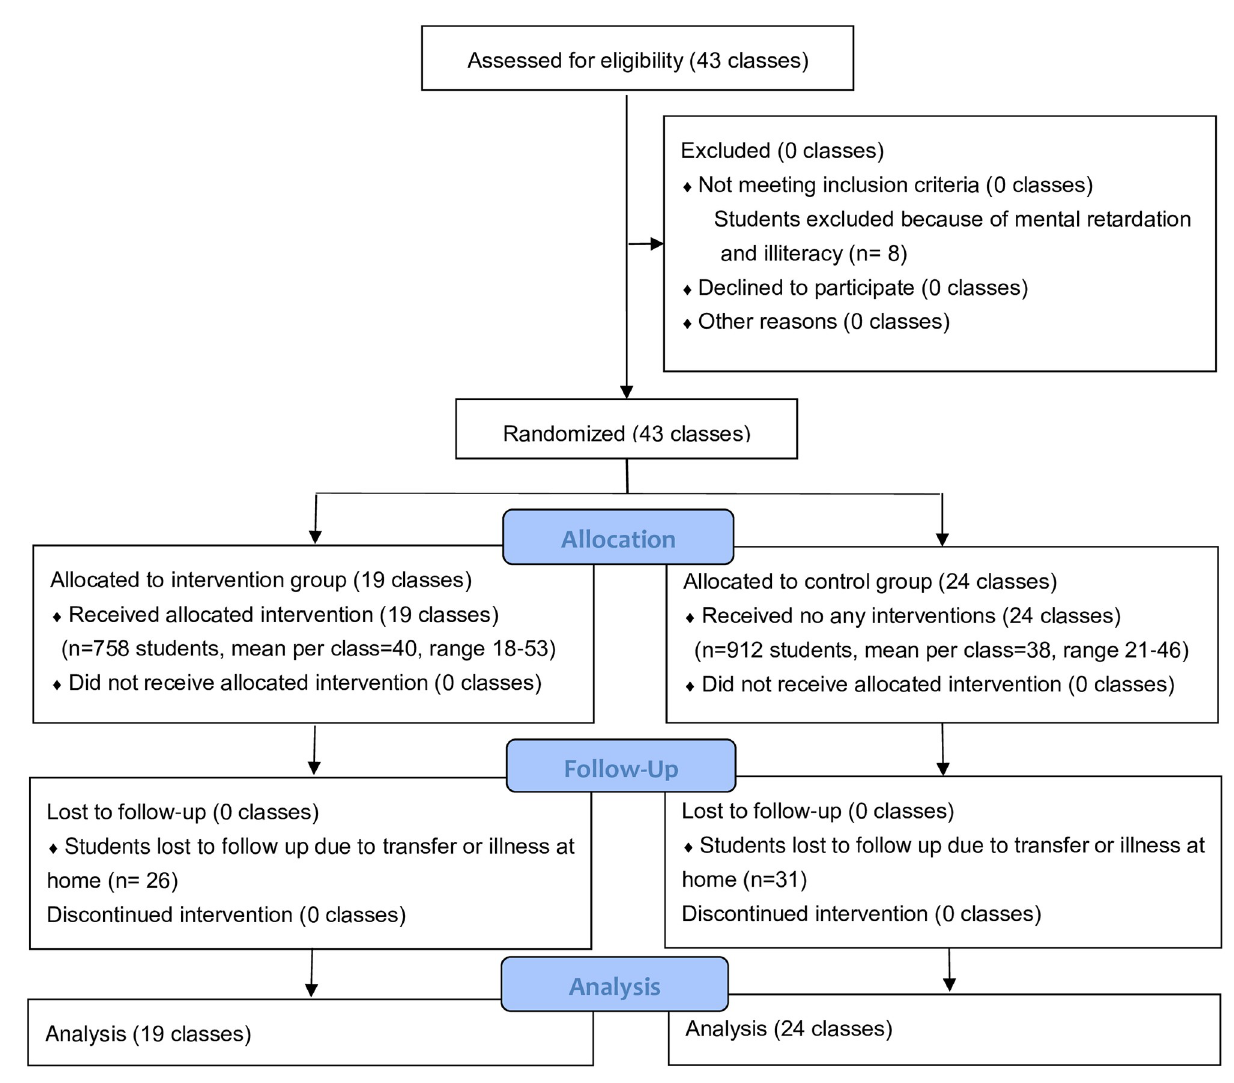
Fig 1. Flow chart of